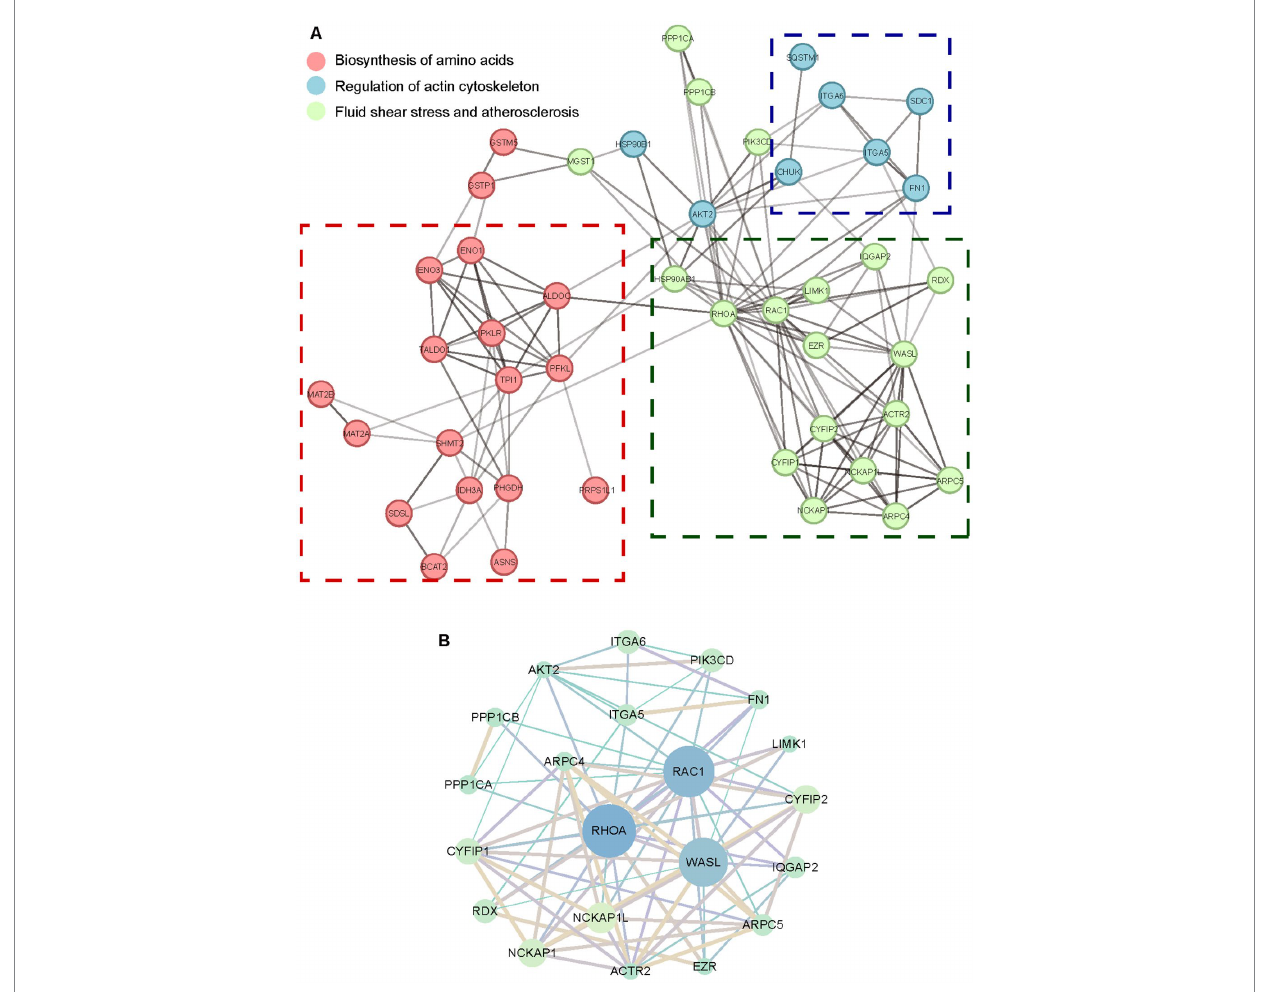
FIGURE 6 The protein–protein interaction network of dysregulated proteins. (A) The STRING network of dysregulated proteins distinguished by k -means. (B) The STRING network of the regulation of actin cytoskeleton. The circle size represents degrees of proteins in each cluster network. The shade of lines represents the combination score between various